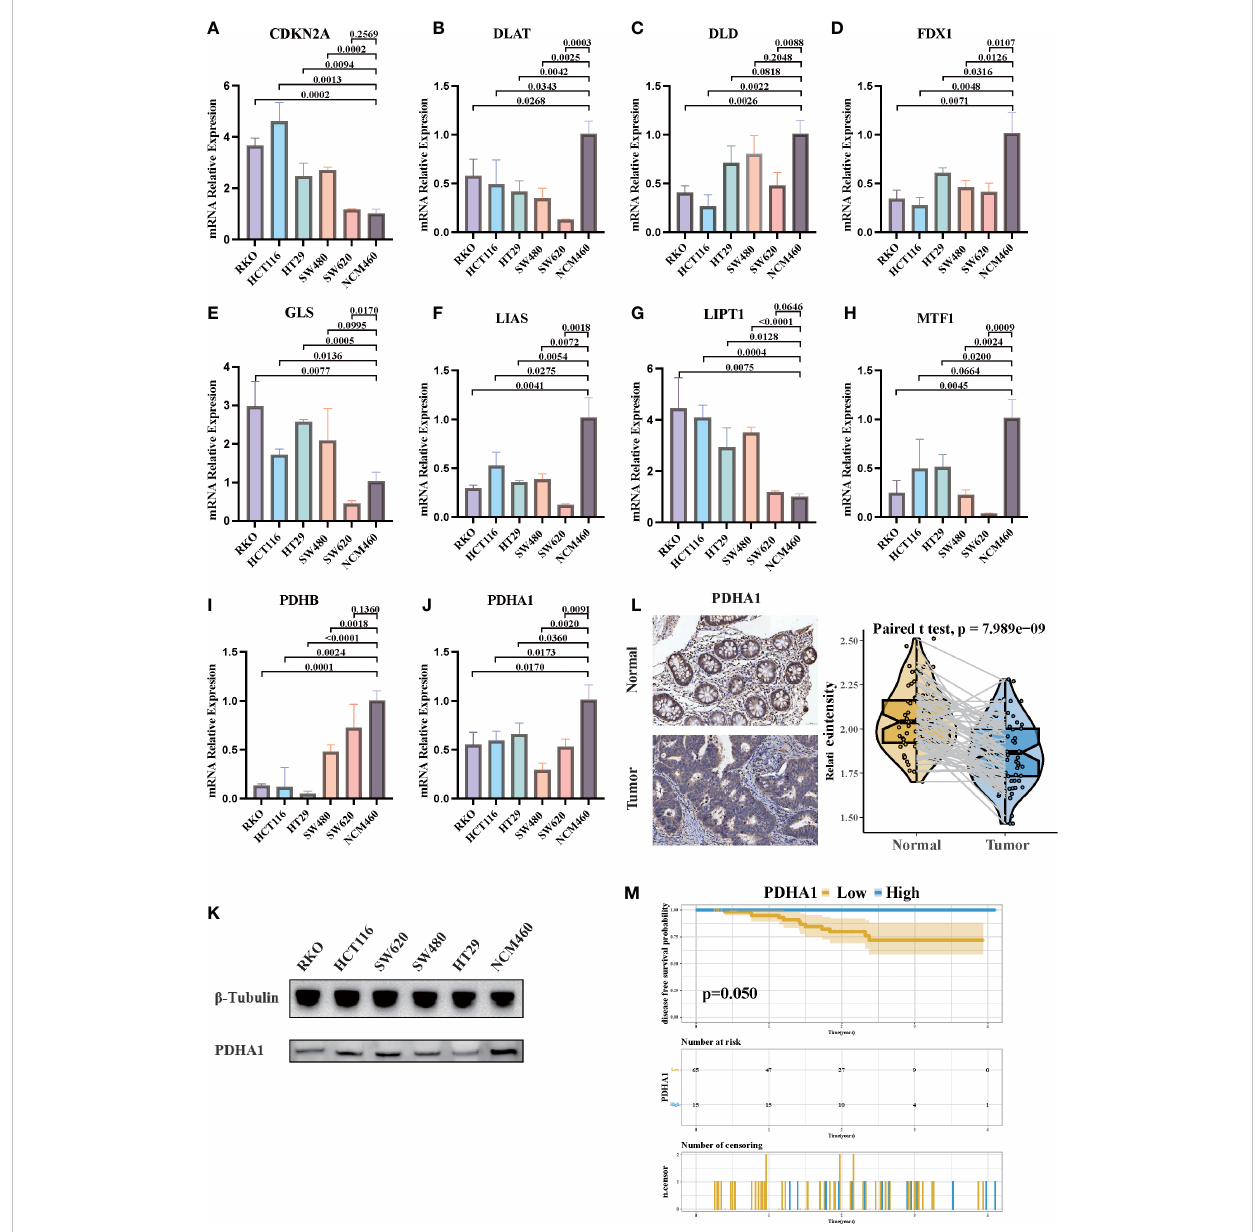
FIGURE 9 The expression of CRGs in CRC cell lines and tissues. (A-J) The mRNA relative expression of each CRG in 5 CRC cell lines and normal colon cell line. The asterisks illustrated the statistical p -value. (K) Western blotting results of PDHA1 protein levels in fi ve CRC cell lines and the normal colon cell line. (L) PDHA1 was downregulated in colorectal cancer tissues compared to normal tissues, as examined by immunohistochemistry. (M) Kaplan – Meier analysis of the disease-free survival rate of CRC patients, which is strati fi ed according to the expression of